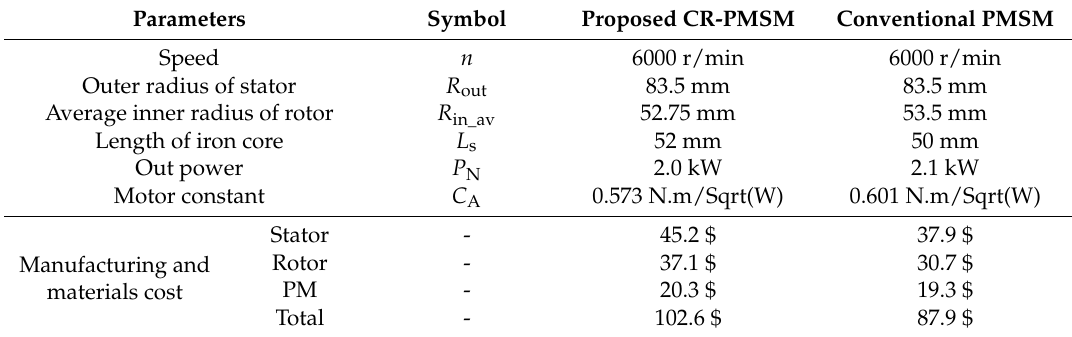
Table 2. Parameters comparison between the proposed CR-PMSM and the conventional PMSM.